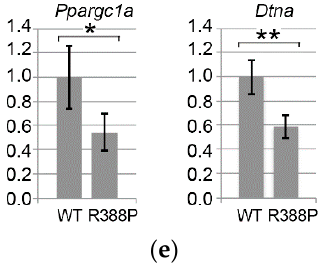
Figure 4. Gene expression related to fiber type determination in TA expressing WT or R388P mutant lamin A. Graphs depict mRNA levels normalized to 18S rRNA for ( a ) Myh2 , Myh1 , and Myh4 mRNAs encoding myosin heavy chains isoforms MHC IIA, MHC IIX, and MHC IIB, respectively; ( b ) Mef2c , Mef2d , and Myog mRNAs encoding key muscle transcription factors MEF2C, MEF2d and Myogenin, respectively; ( c ) Hdac1 , Hdac9 , and Sirt1 mRNAs encoding histone deacetylases HDAC 1, HDAC 9 and SIRT1, respectively; ( d ) MyoD , Six1 , and Eya1 mRNAs encoding Myod and related co-factors SIX1 and Eya1, respectively; and ( e ) Ppargc1a and Dtna mRNAs encoding two proteins related to muscular atrophy and dystrophy, PGC1 α and Dystrobrevin α , respectively. Data represent mean ± s.e.m ( n = 12 for WT lamin A; n = 10 for mutant lamin A). * p = 0.05; * * p < 0.05